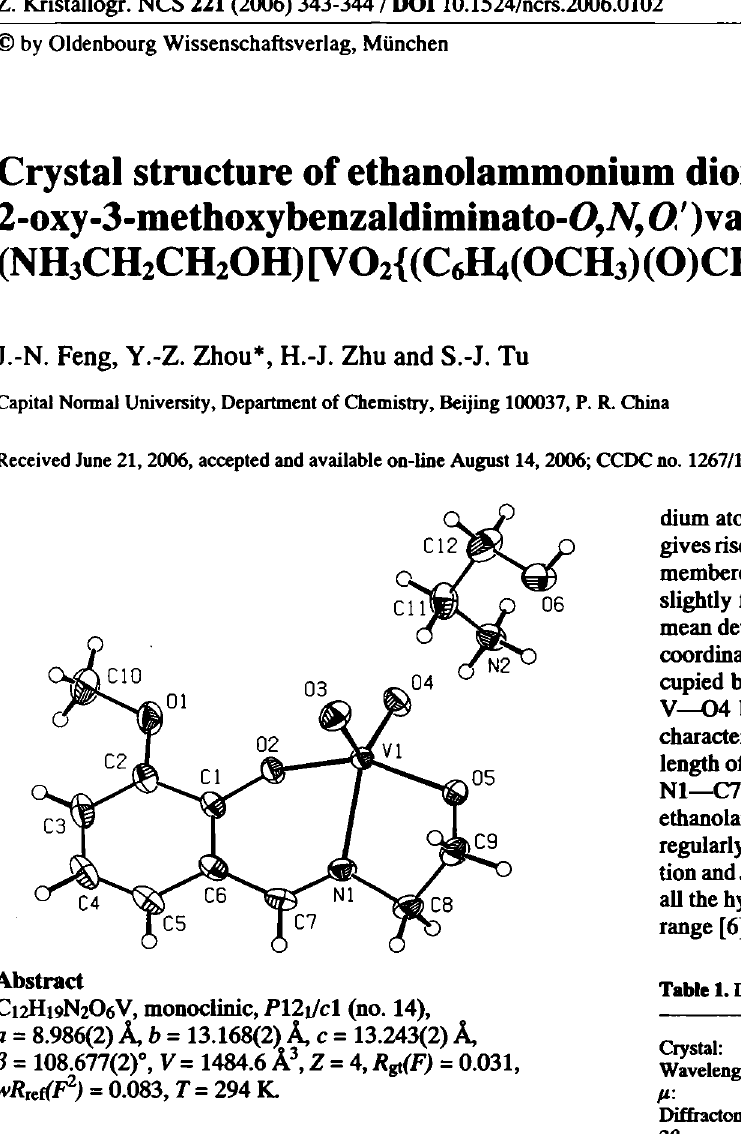
Table 2. Atomic coordinates and displacement parameters (in A 2